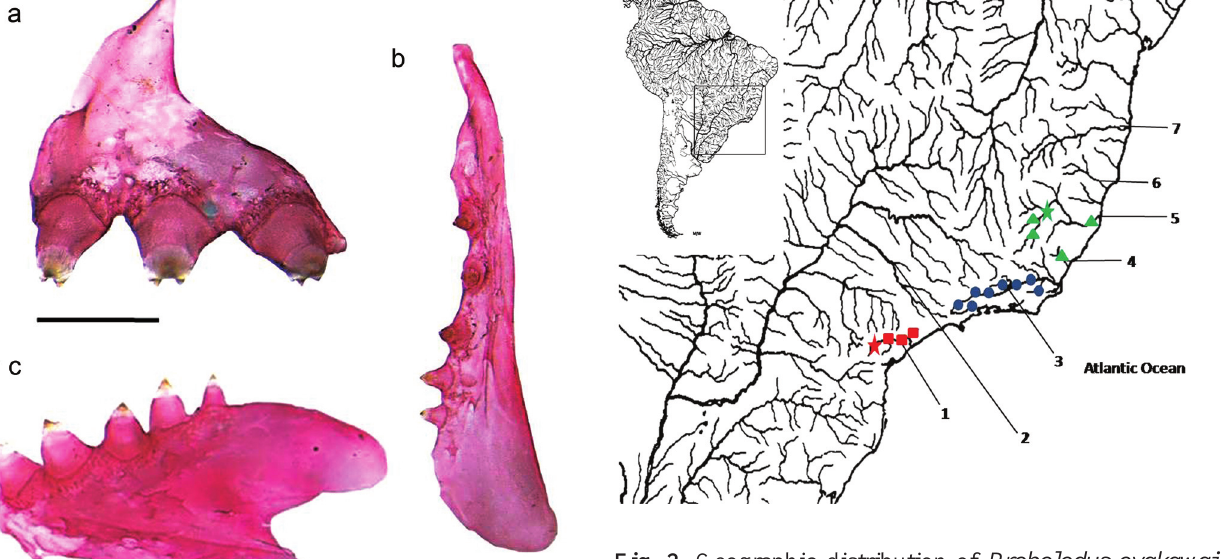
Fig. 2. Geographic distribution of Probolodus oyakawai (squares), P. heterostomus (circles), and P. sazimai (triangle); star indicates type locality. 1) rio Ribeira de Iguape, 2) rio Tietê, in upper rio Paraná basin, 3) rio Paraíba do Sul, 4) rio Itapemirim, 5) rio Doce, 6) rio Mucuri, 7) rio Jequitinhonha. Symbols may represent more than one